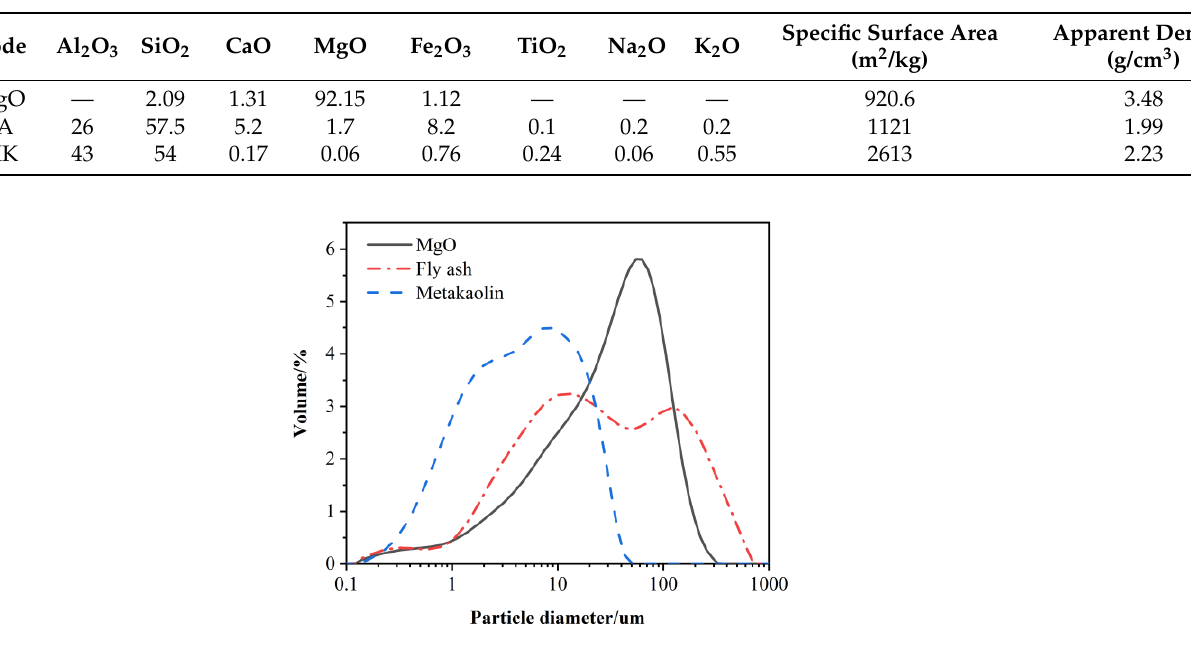
Table 1. Physical properties and chemical composition of raw materials (by wt/%).